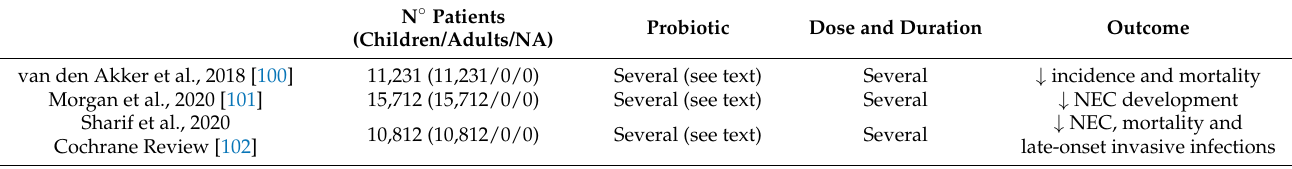
Table 13. Meta-analyses and systematic reviews on probiotics in necrotizing entero-colitis and late onset sepsis. N ◦